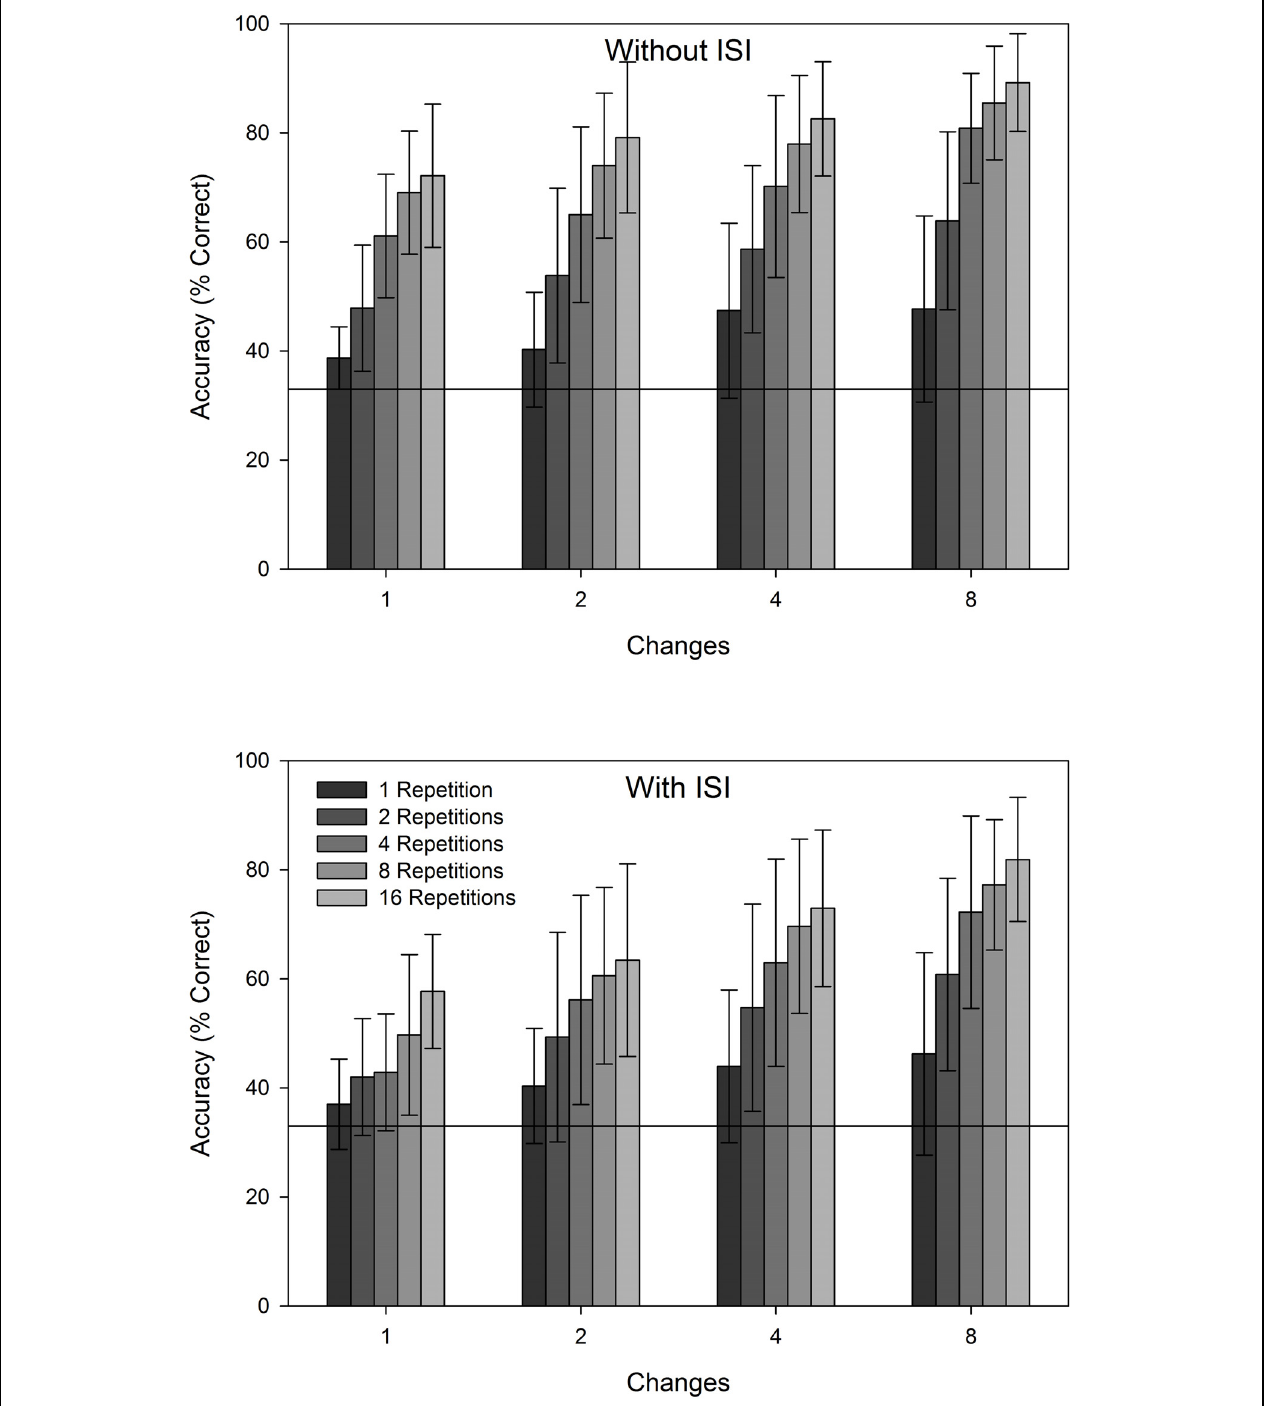
FIGURE 2 | Change detection accuracy over the 10 days of each condition as a function of number of changes, number of repetitions, and ISI presence. Error bars depict 95% confidence intervals.